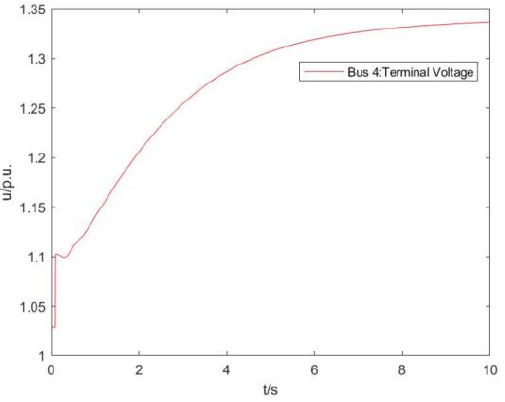
Figure 13. Voltage changes of key nodes in the system (VSG not considered).